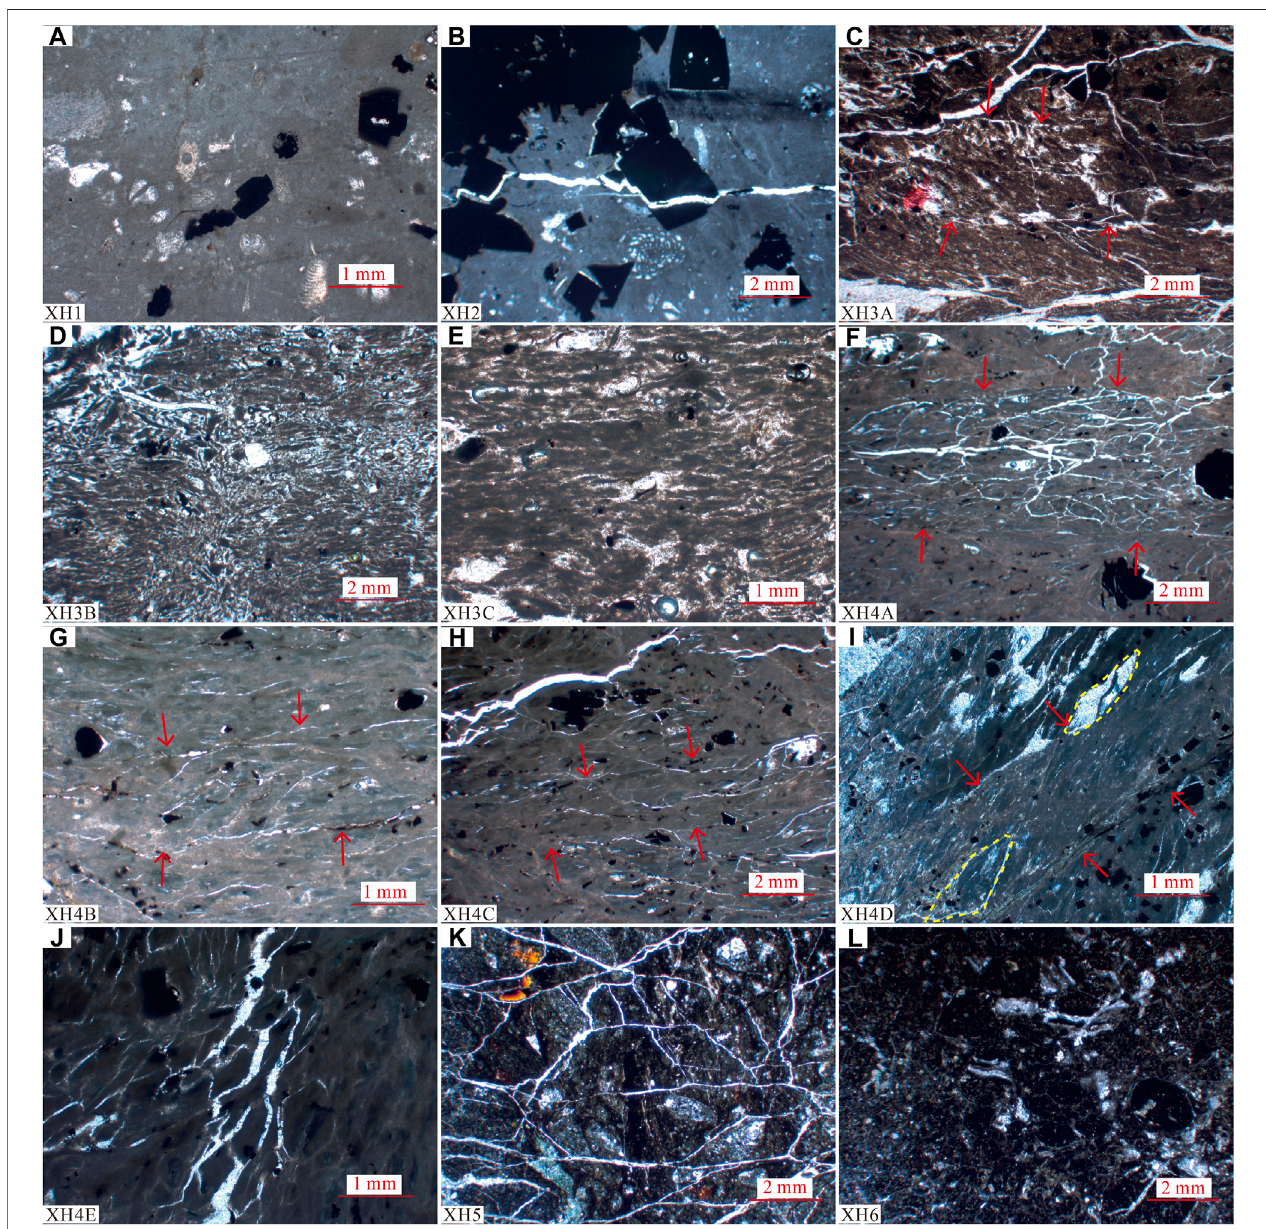
FIGURE 7 | Typical photomicrographs of samples from the Xiaohe site showing details of the microstructures. (A) XH1. (B) XH2. (C – E) XH3. (F – J) XH4. (K) XH5. (L) XH6. Arrows denote individual straight cracks and the localized deformation zones delimited by them.